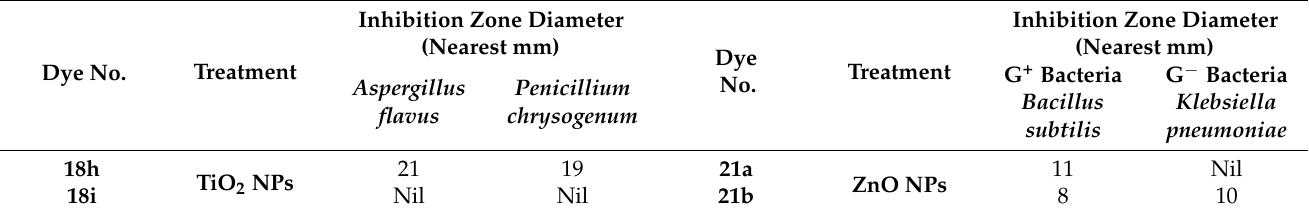
Table 8. Antimicrobial activity of the treated dyed polyester fabrics with TiO 2 NPs or ZnO NPs.